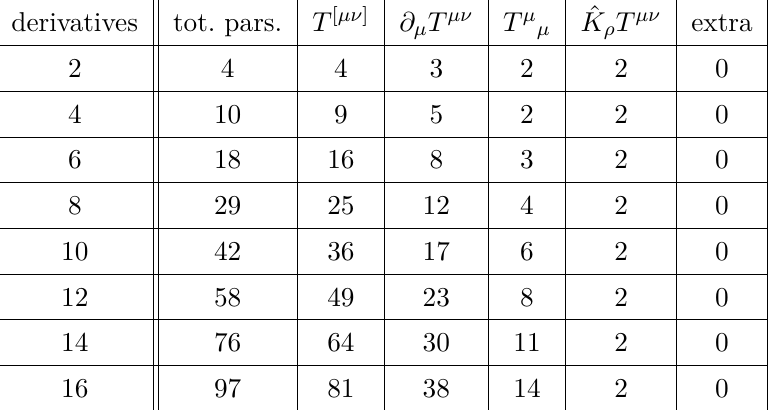
Table 1 . In each row the numbers indicate the leftover parameters after successive applications of the on- and off-shell conditions on the ansatz of T µν . Notice that the two extra conditions on the off-shell divergence and trace always fix the two parameters left over by the application of the others. These two parameters are always associated with the coefficient of the term η µν φ ( ∂ 2 ) n φ , which is not fixed on-shell, and the overall normalization of the other terms (likewise the parameter a 1 in (3.8) for the n = 1